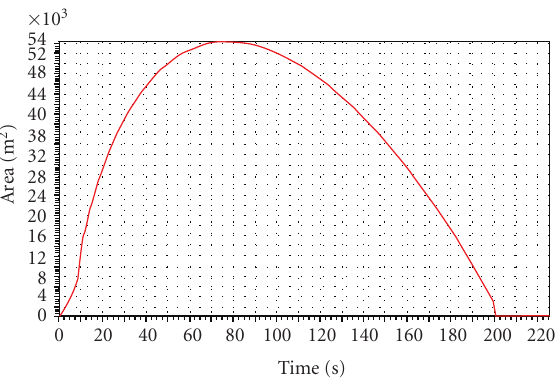
Figure 14: Area of cloud T2302.